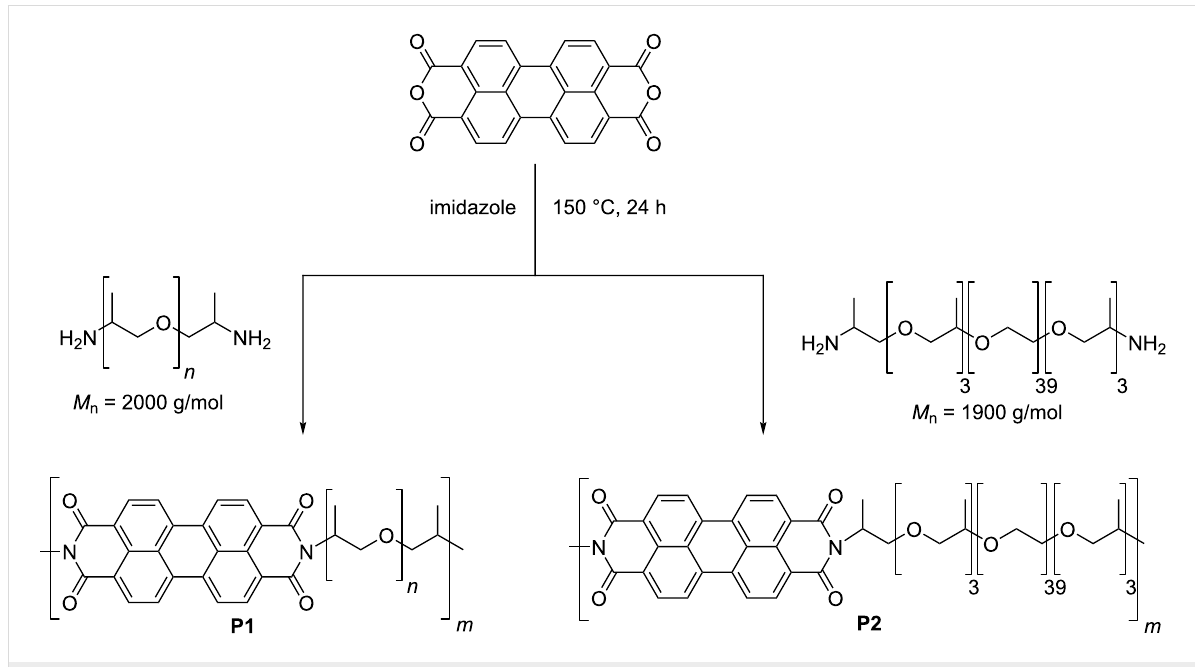
Scheme 1: Schematic representation of the polymer synthesis of P1 and P2